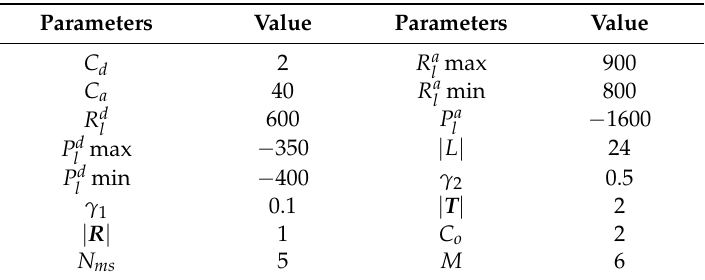
Figure 2. Layout of the case study (the triangles indicate the high-accuracy air quality monitoring stations, while the circles represent gas sensor modules in this figure). Table 3. Value of